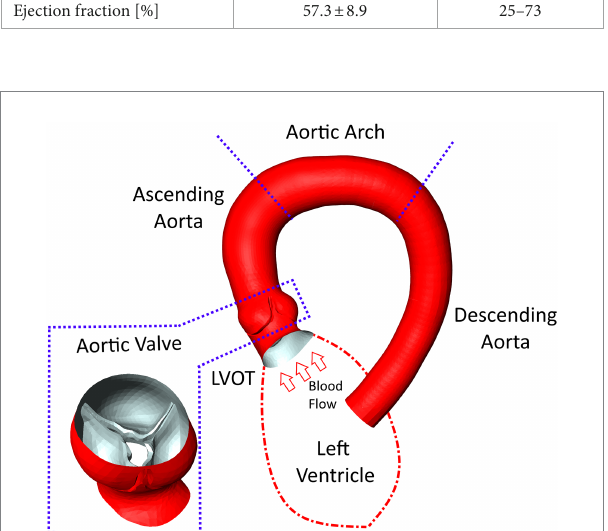
FIGURE 1 Surface model of the aorta and aortic valve of a typical case with severe aortic stenosis. Additionally, labels for the various parts of the aorta are provided as well as a schematic depiction of the left ventricle attached to the left-ventricular outflow tract (LVOT).